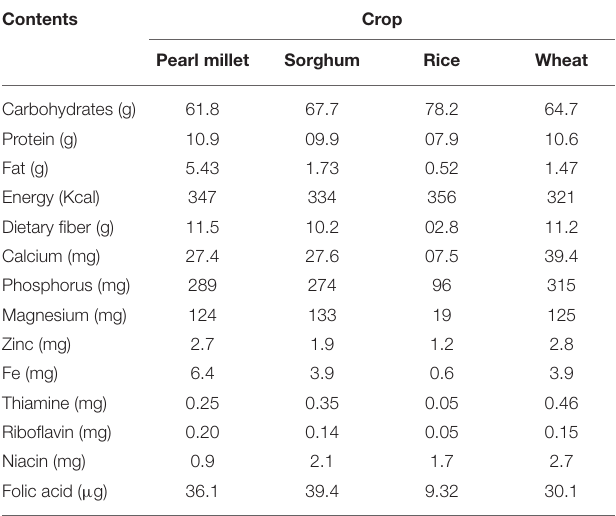
TABLE 3 | Nutritional comparison of pearl millet with sorghum, rice, and wheat (in 100g